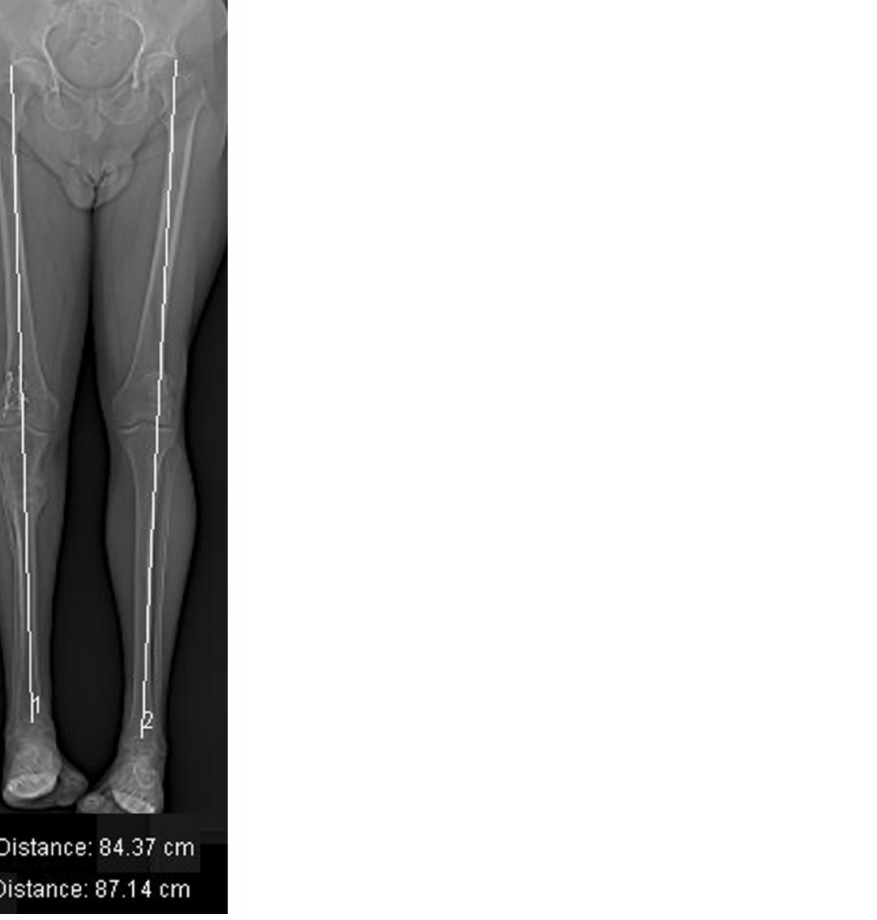
Figure 5. Length measurement of the lower limb to plan bone-lengthening surgery. The measurement shows a 2.8 cm